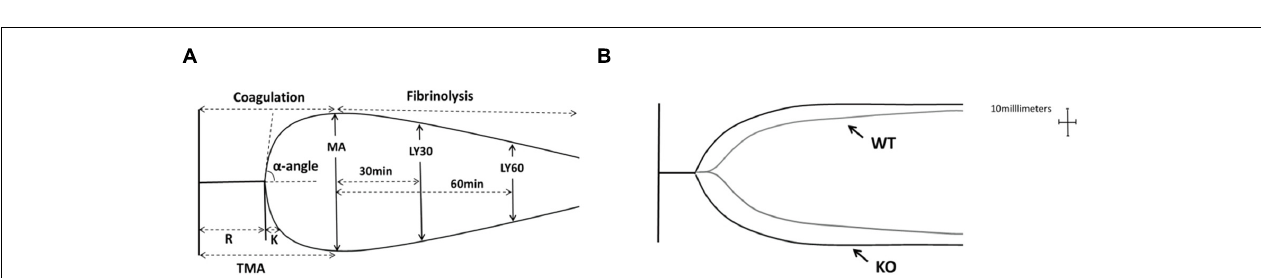
FIGURE 4 | P311 overexpression promotes proliferation of primary mouse fibroblasts (MPF). (A) Representative morphology of primary mouse fibroblasts (MPF) transfected with Ad-P311 or a negative vector (GFP). Transfected for 48 h and then observed under a fluorescence microscope to confirm the infection efficiency by visualizing GFP expression. Scale bar = 100 mm. (B) Quantitation data of GFP + cells fraction in P311 transfected MPFs and vector group to determine the transfection efficiency. (C) P311 mRNA level in P311 transfected MPFs and vector group ( n = 4 per group). (D) Representative flow cytometry cell cycle. (E) Quantitation data of flow cytometry cell cycle ( n = 6). (F) The CCK8 assay was performed to assess the effect of P311 on the proliferation ( n = 6). ∗ P < 0.05, ∗∗ P < 0.01, Ad-P311 vs. Ad-Vector.